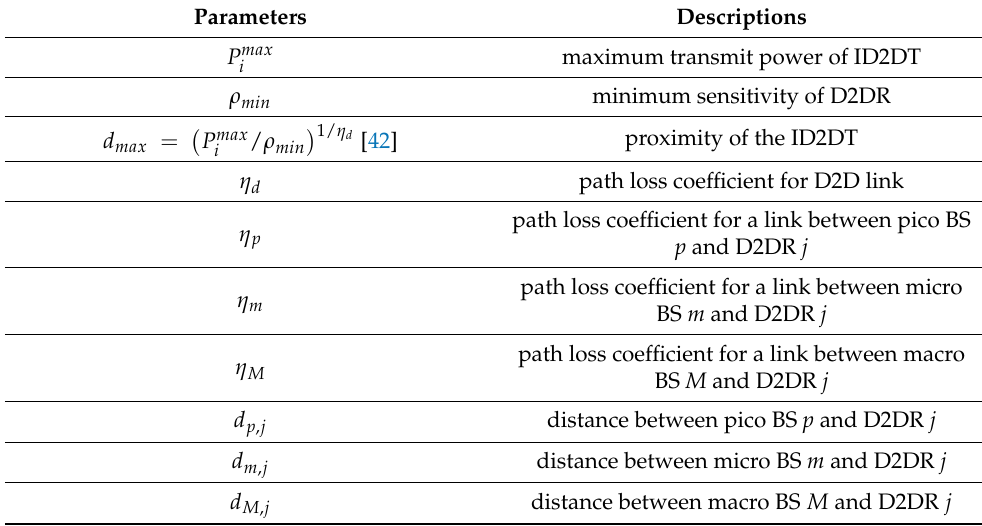
Table 1. System-related parameters.